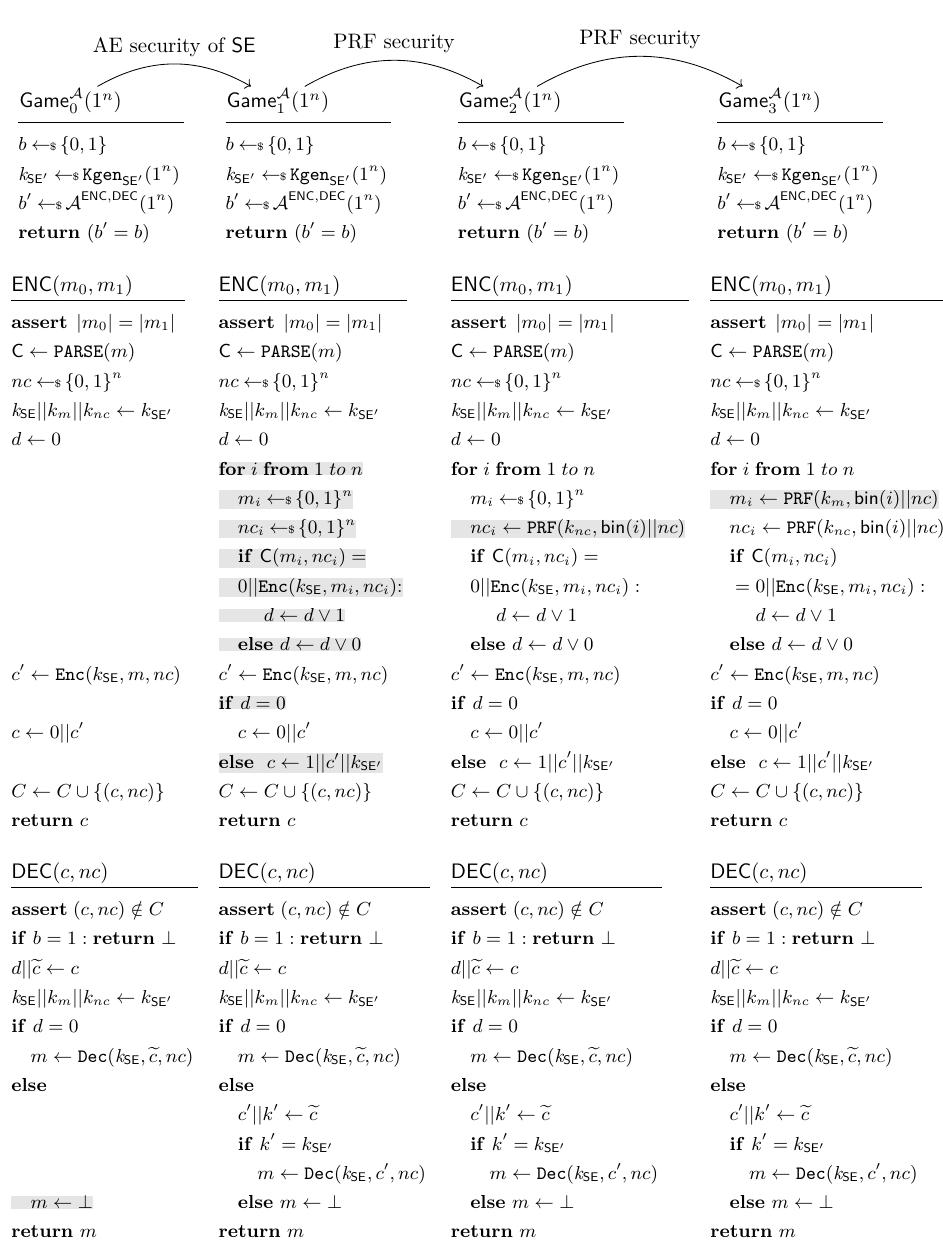
Figure 4: Definition of the